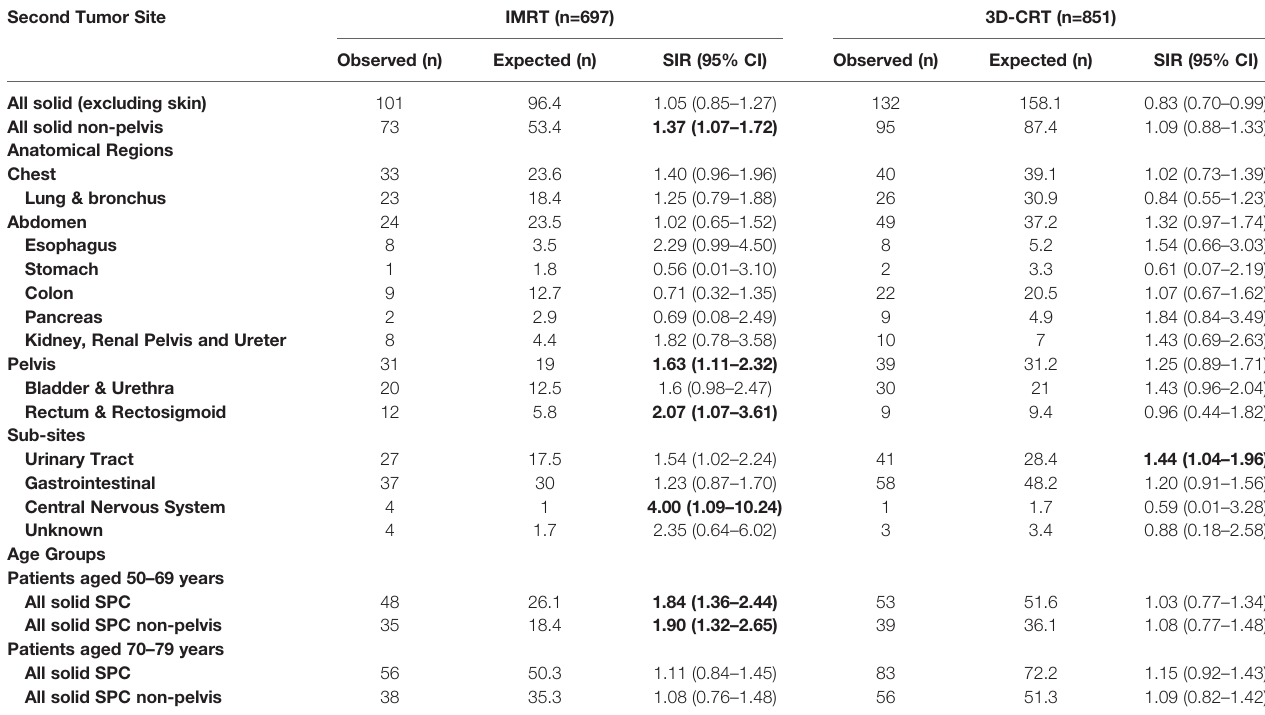
TABLE 3 | Standardized Incidence Ratios (SIRs) for the IMRT and 3DCRT cohort compared to the general Dutch male population, adjusted for age and calendar year. Second Tumor